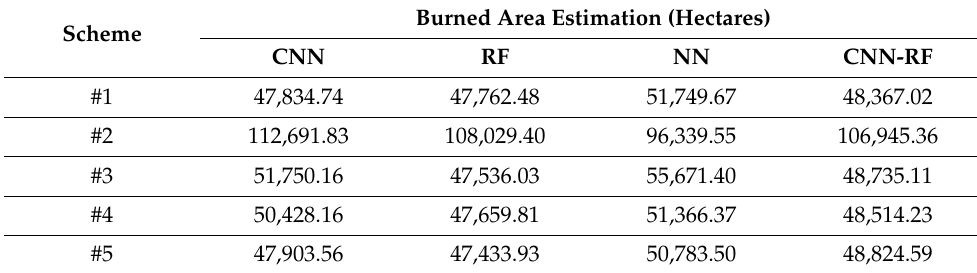
Table 4. Burned area estimation using CNN, RF, NN, and CNN-RF methods.